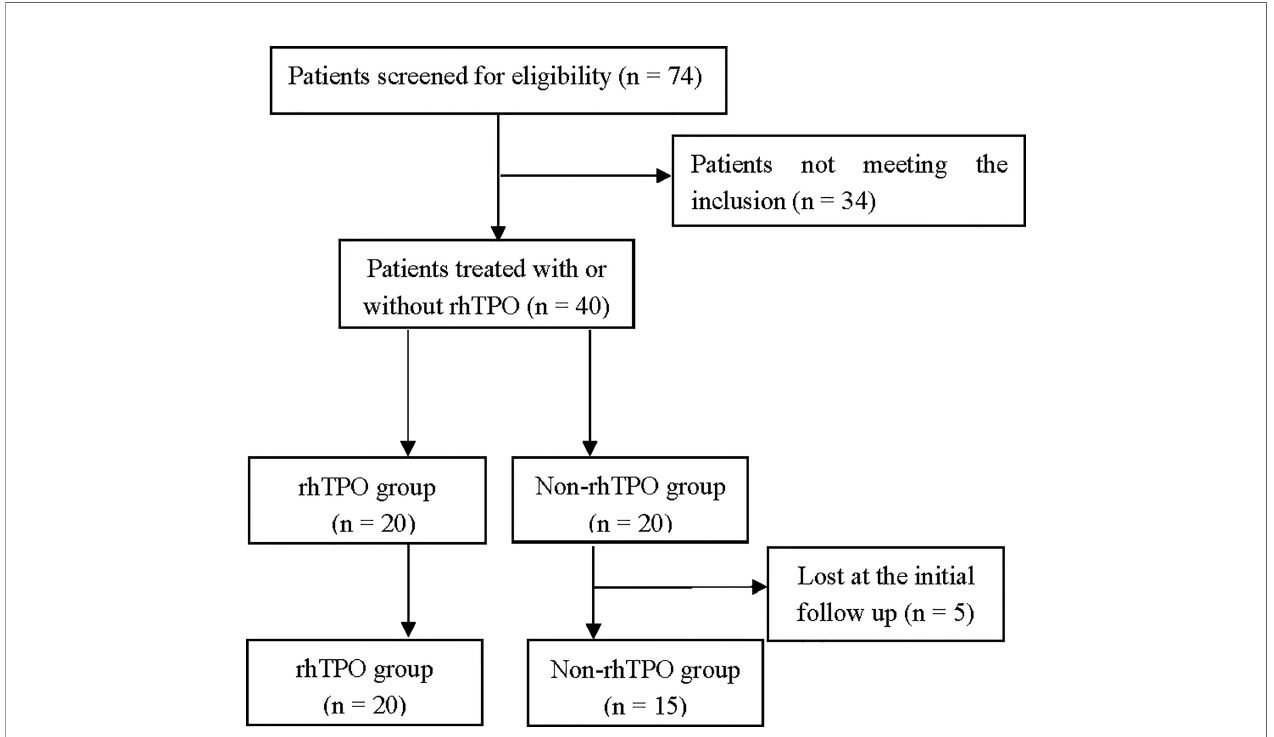
FIGURE 1 | Trialpro fi le. Seventy-fourpatients were screenedfor eligibility;34 patients were excluded for not meeting theinclusion criteria. Forty patients were ultimately enrolled, of whom 20 were assignedto the recombinant humanthrombopoietin (rhTPO)groupand theother 20 to thenon-rhTPO group. Five patients in thenon-rhTPO group were lost within 3 months at theinitial follow-upand were excluded from the fi nal analysis. The remaining35 patients completed thedesigned